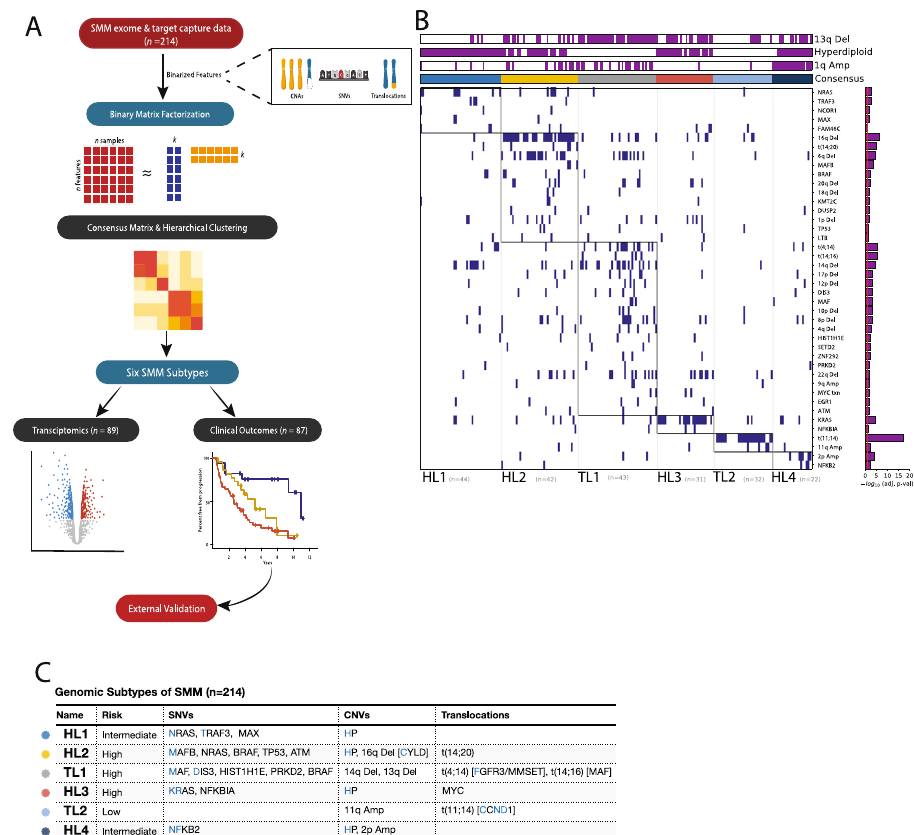
Fig. 1 Outline of the study and the six molecular subtypes identi fi ed based on DNA alterations in tumor samples from smoldering myeloma patients. A Flowchart of analyses was performed in this study. Clusters were generated based on the tumor genetic alterations from DNA sequencing data, then they were analyzed for correlations with transcriptomic and clinical data. This fl owchart was created with BioRender.com. B Identi fi cation of groups of tumors with corresponding genetic events. Binary matrix factorization consensus clustering was performed using somatic mutations, somatic copy number alterations, and translocations from 214 SMM tumor samples (columns). Clusters HL1 – 4, TL1, and TL2 with their associated landmark genetic alterations are visualized (boxed for each cluster). Genetic alterations that were positively associated with each cluster were identi fi ed by a one-sided Fisher test and ranked by signi fi cance (Benjamini – Hochberg adjusted p value < 0.1, red line, bar graph to the right). C Summary table of the six subtypes identi fi ed with selected enriched genetic